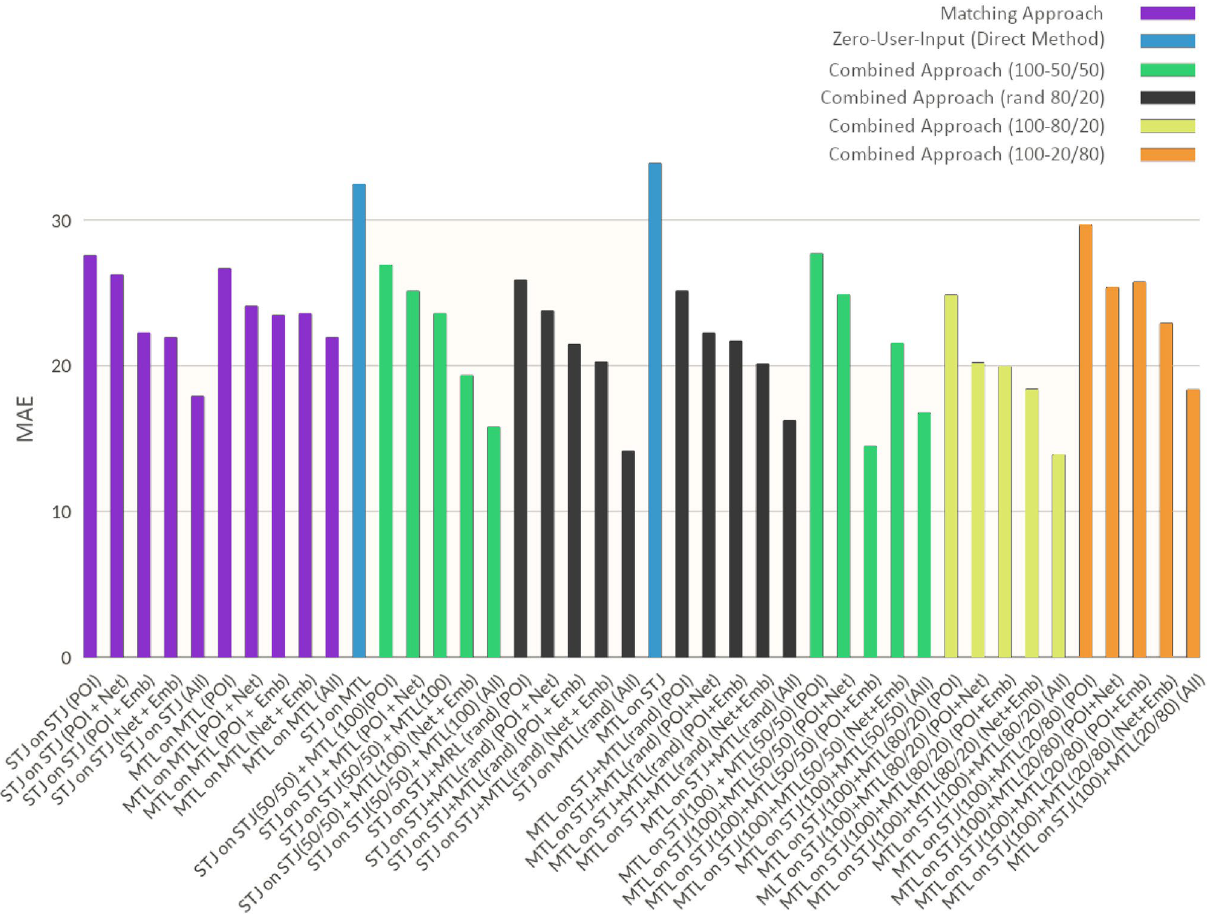
Figure 4. Exploration of 3 approaches (1) matching, (2) combined, (3) zero-user-input. Combined approach is extensively tested with various conditions. One such condition is the different ways of data split to better understand how the data affects the transfer of knowledge in transfer learning while being able to provide solid training and testing sets. Best performance was observed to be generated through a complete random selection into an 80–20 split. MTL on STJ reflects on the prediction of scores for Montréal based only on a model trained on St. John’s. MTL on STJ+MTL on the other hand reflects on the prediction of scores for Montréal based on a transfer-learned model on both St. John’s and Montréal. (Bar plot generated through matplotlib 45 Version 3.4.3 from